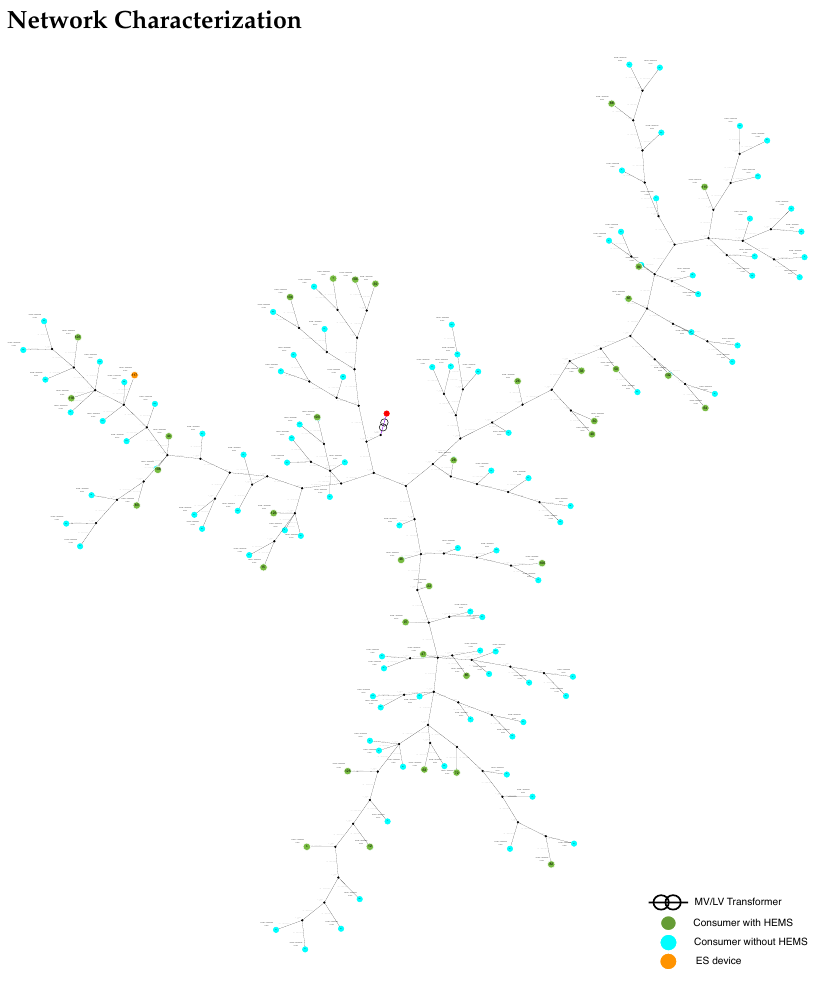
Figure A1. Simulation network characterization. Single-line